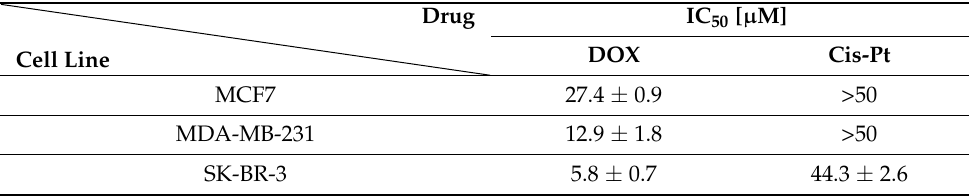
Table 2. IC 50 values determination for doxorubicin or cisplatin after MCF7, MDA-MB-231 or Sk-BR3 cells treatment for 24 h. IC 50 values were calculated using CompuSyn program (three biological repeats, six technical repeats each, were